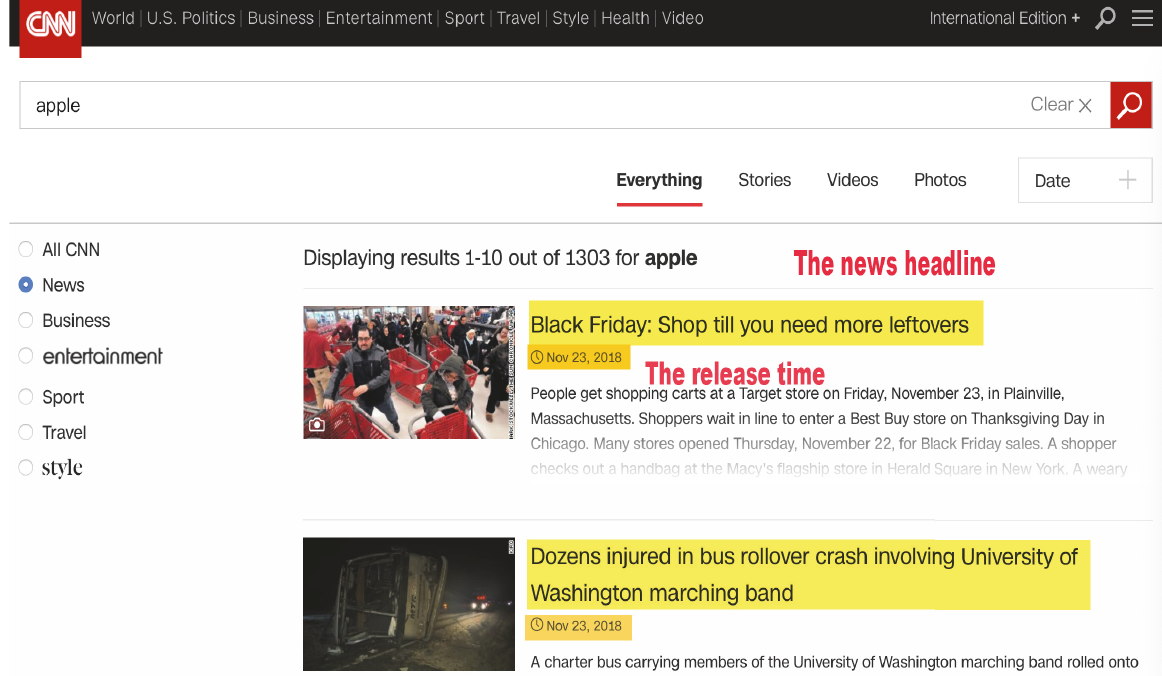
Figure 2: Example of collected financial news in